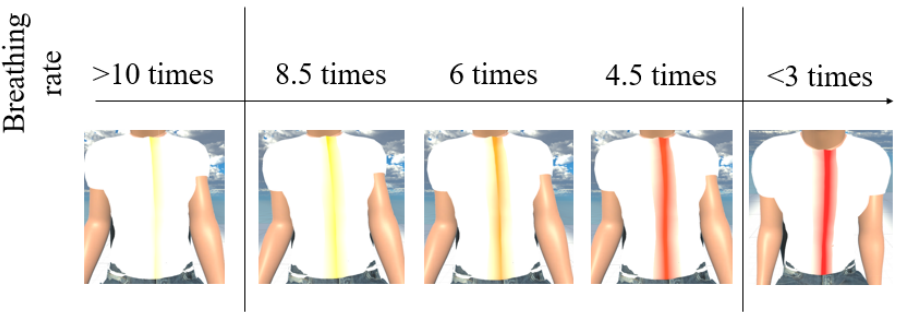
Figure 7. The visualization of changes of body temperature.